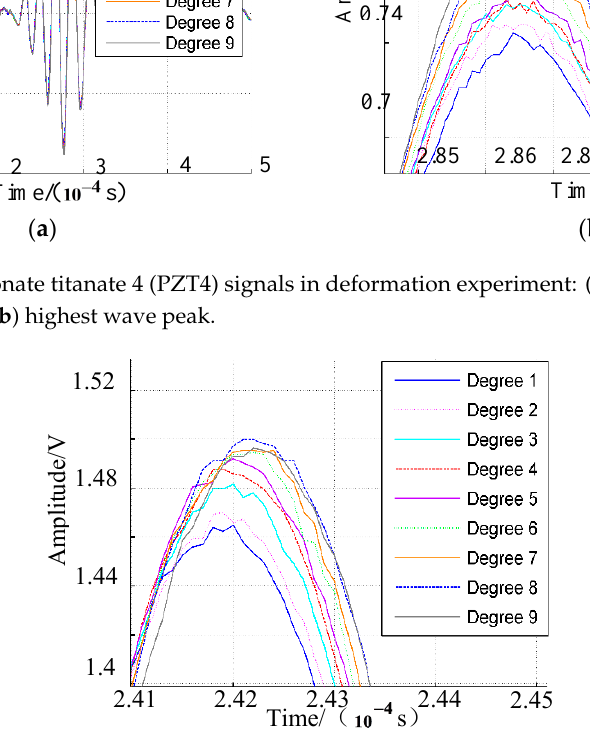
Figure 4. Highest wave peak when PZTB was excitation sensor.